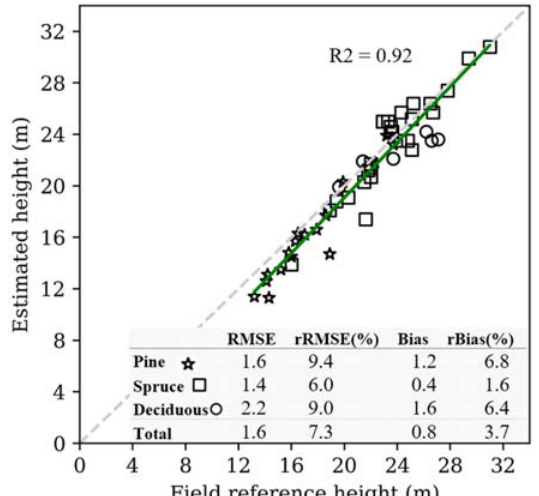
Figure 7. Mean tree height estimation (meter) using local maxima method with SPL data per each and all species classes.